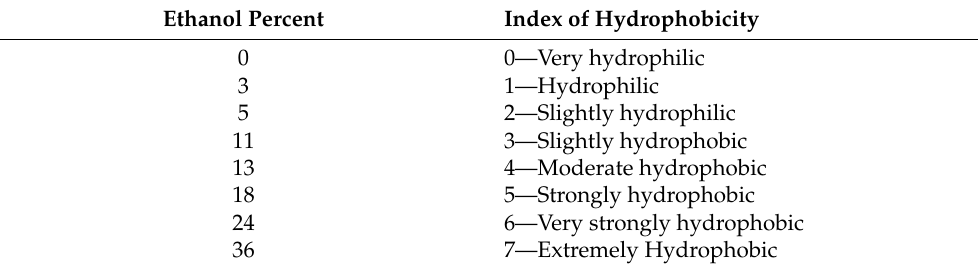
Table 1. Correlation of ethanol% with hydrophobicity index in MED